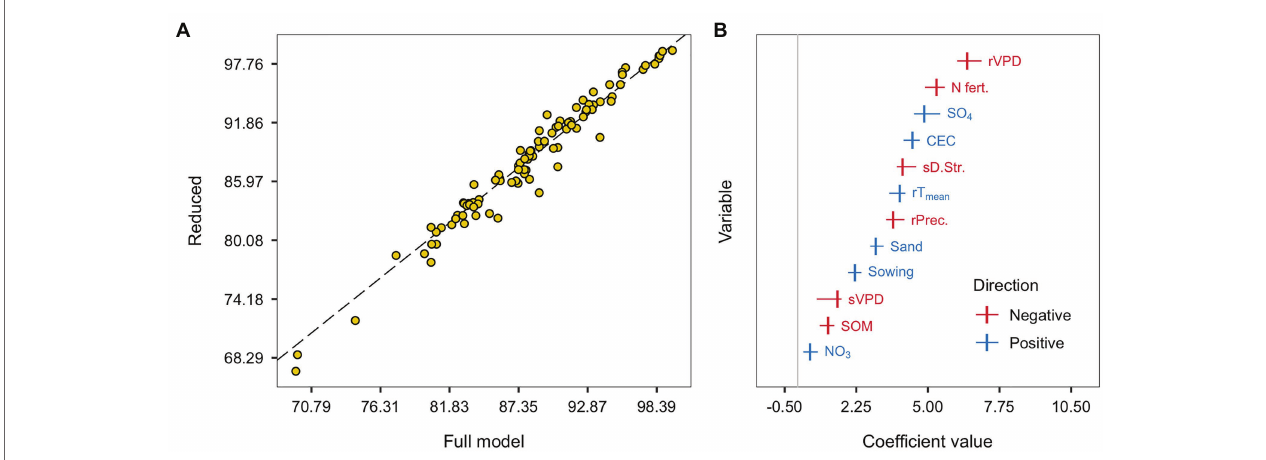
FIGURE 4 | The overlaying of predicted values of the full and reduced model for the RAU. The dashed black line indicates the 1:1 relation (A) . Centered and scaled covariables coefficients of the reduced linear regression model. Colors indicate the coefficients directions: negative are reds and positive are blues. Points represent the median from the 20 training-test combinations, while horizontal lines range from the minimum to the maximum coefficient values across sets (B)